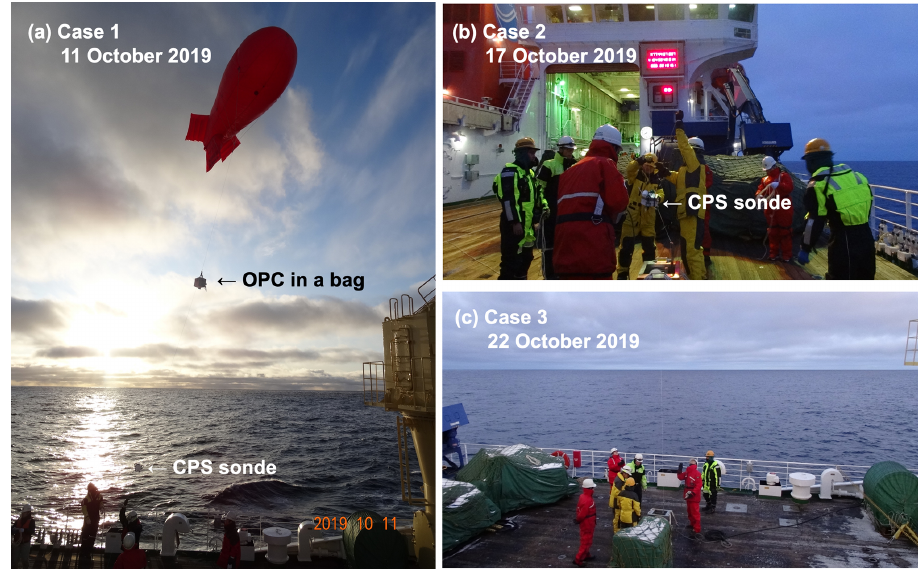
Figure 4. Photographs of tethered balloon measurements for the cases of (a) 11 October 2019 (MR19-CPST1), (b) 17 October 2019 (MR19- CPST2), and (c) 22 October 2019 (MR19-CPST3) on RV Mirai in the Arctic